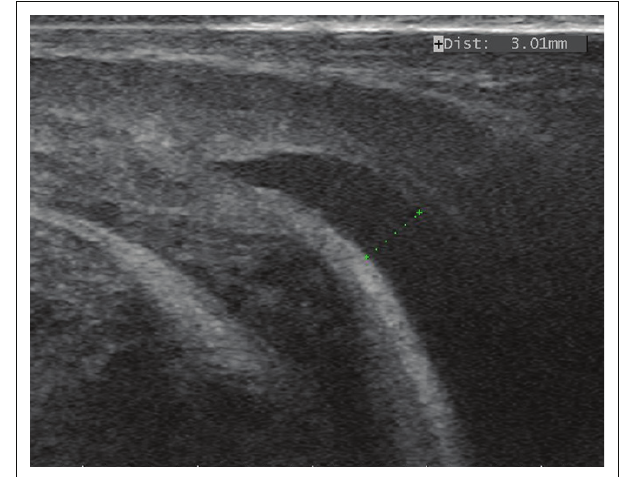
FIGURE 2: An ultrasonographic evaluation of the distal urethra showing a hyperechoic mass obstruction, 3.75 mm in diameter, proximal to the glans